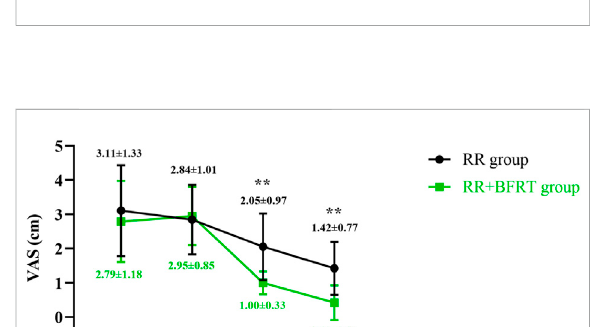
FIGURE 10 Intra-group comparison of VAS scores in RR group and RR + BFRT group. “ ** ” indicates a signi fi cant change ( p < 0.01). Values are presented as mean ± SD. RR Group: routine rehabilitation group; RR + BFRT Group: routine rehabilitation + blood fl ow restriction training group.